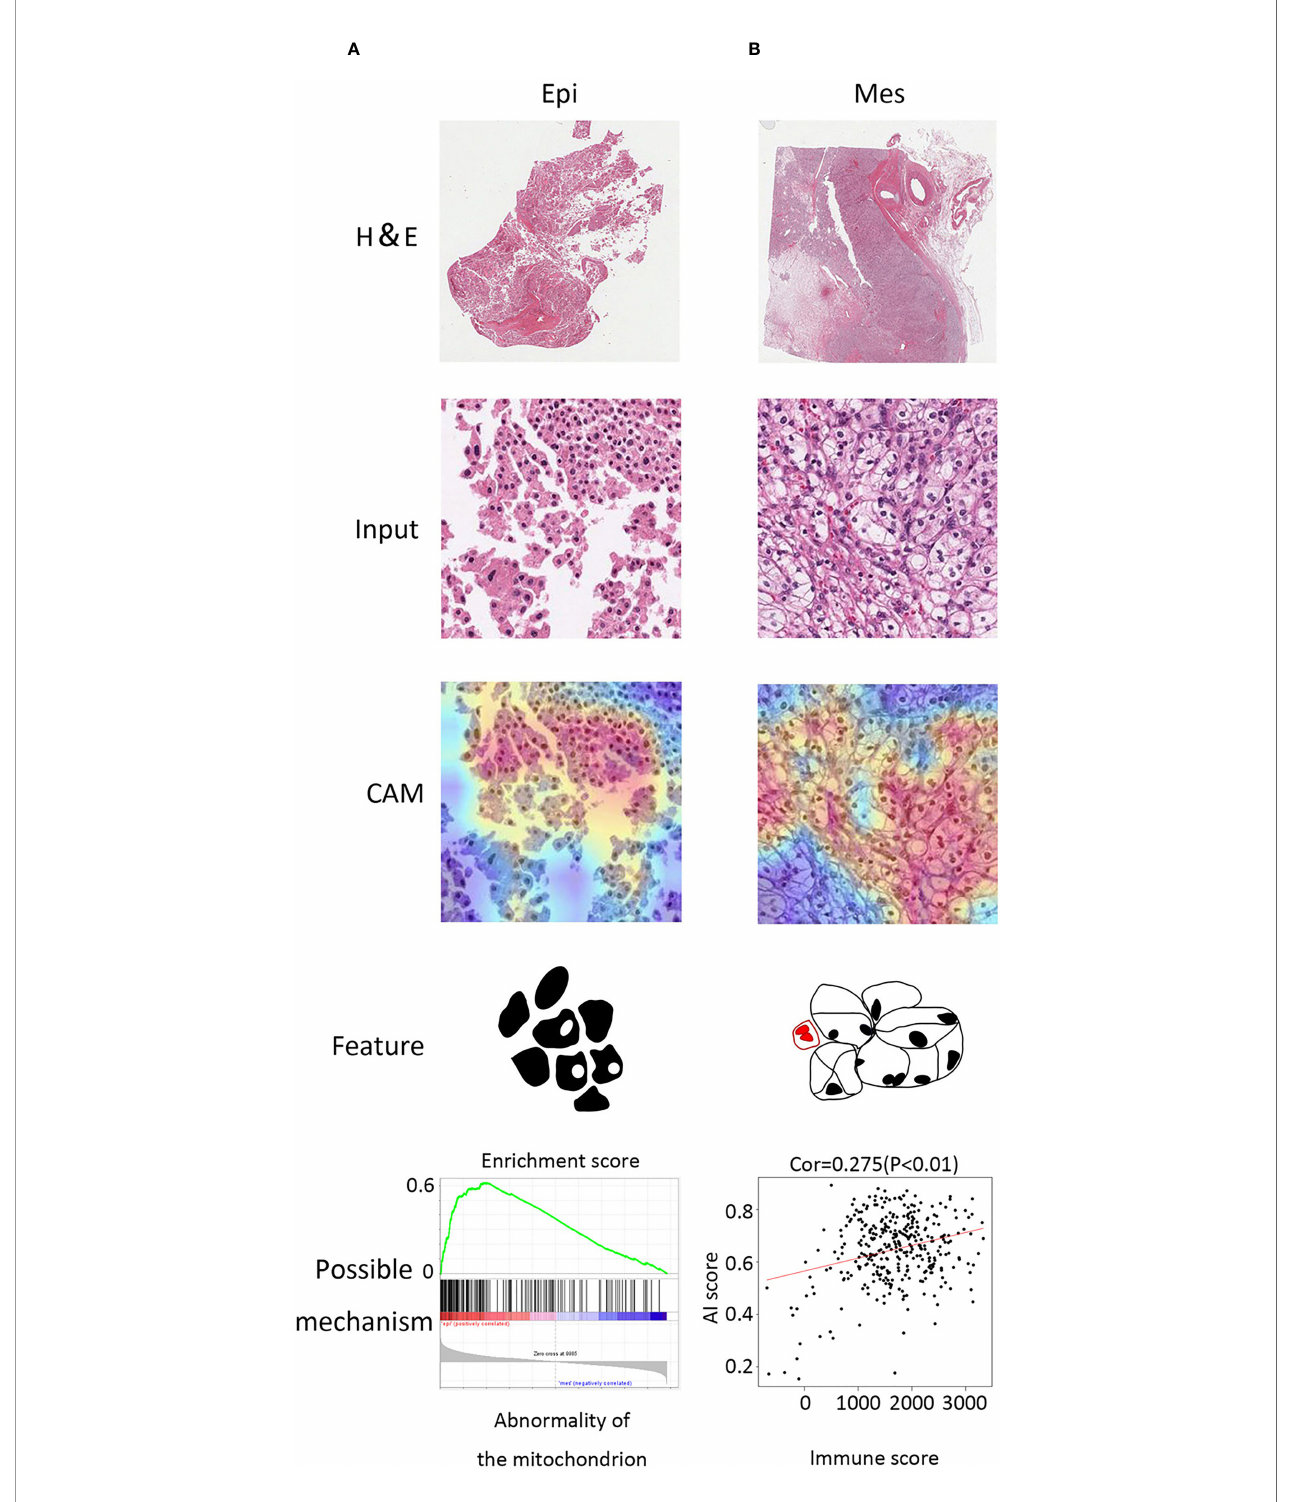
FIGURE 4 | Class activation maps for morphological features. (A) Macrograph (top), input image (second from top), CAM (third from top), and corresponding sketch maps of predominant morphological feature (bottom) for EMT subtypes (from left to right: Epi and Mes). Epi region is a granular eosinophilic cytoplasm area with a looser arrangement, big cell gap, nucleoli absent. Mes region contained mostly tumor cells with empty cytoplasm and mixed with immune cells. (B) GSEA plot of abnormality of the mitochondrion in Epi cluster (left) and positive correlation between AI score and immune score (estimated by the ESTIMATE